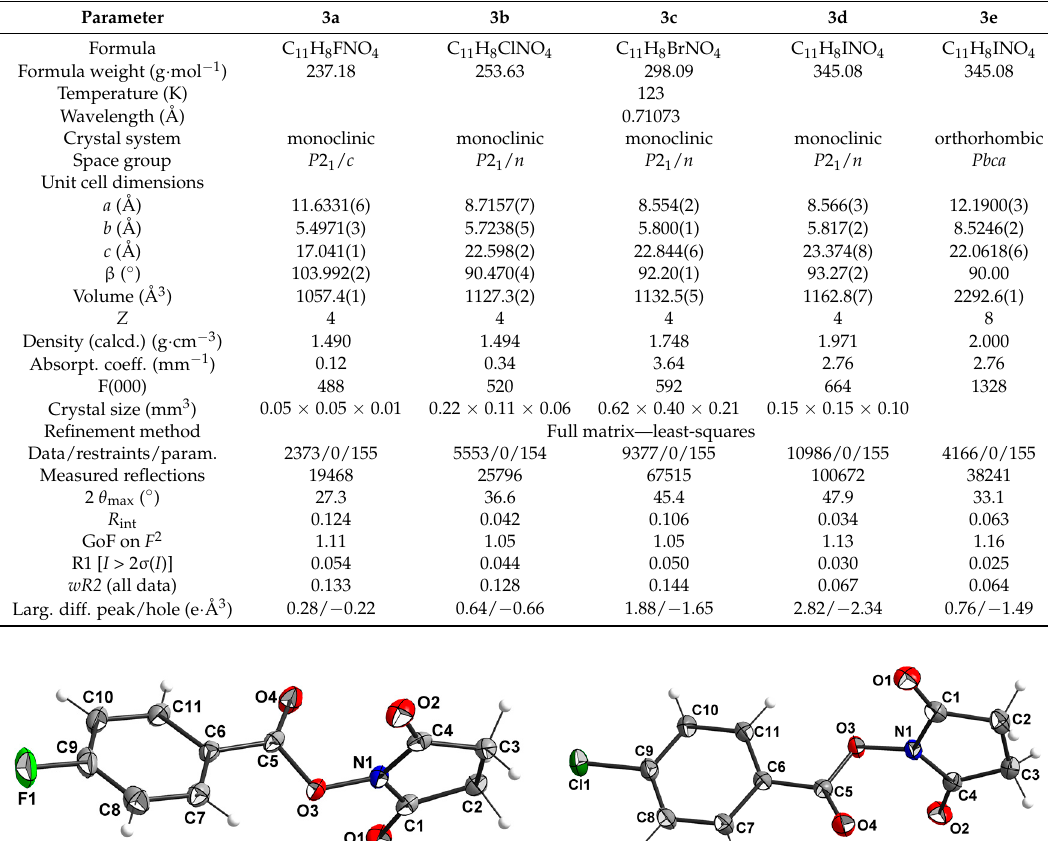
Table 1. Crystal data and structure refinement for compounds 3a – e .